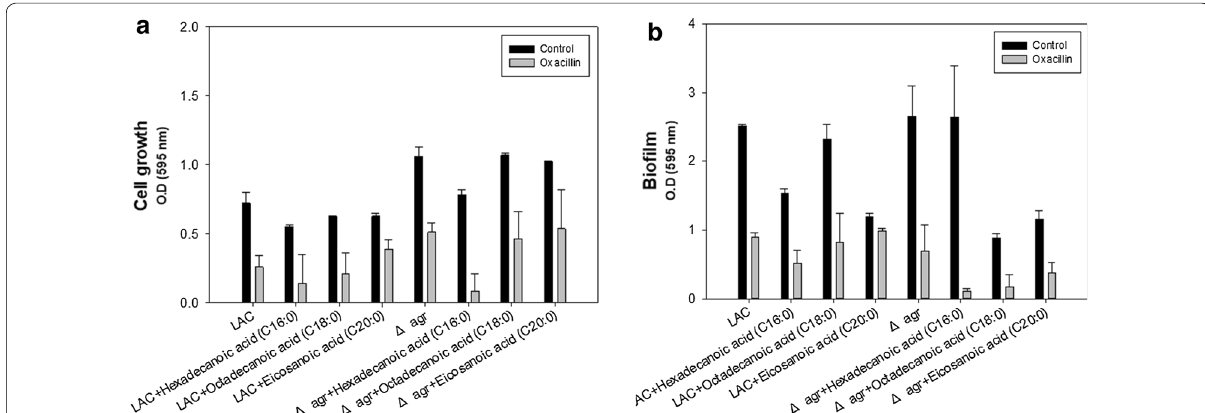
Fig. 4 Synergistic effect of oxacillin with artificially added fatty acids. a Cell growth of the LAC and Δ agr mutant strains with the addition of long‑chain fatty acids. b Biofilm formation of the LAC and Δ agr mutant strains with long‑chain fatty acids. The cell was grown for 48 h in the presence of 100 μg/mL of the fatty acid supplements for the comparative analysis of cell growth and biofilm formation. The error bars represent the standard deviation of three replicates